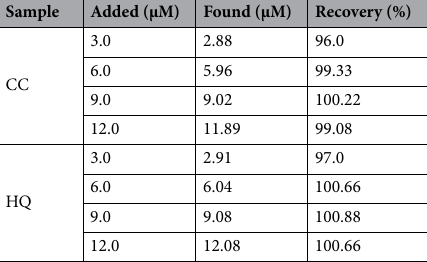
Table 6. Results obtained for CC and HQ determination in tap water sample at polysorbate/CPE (n = 3).